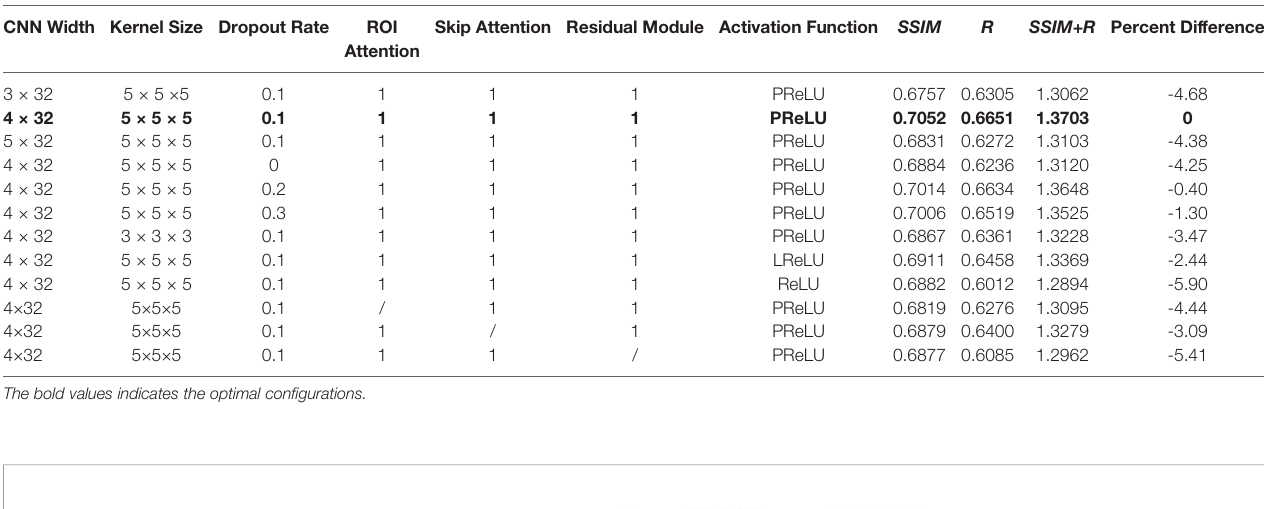
TABLE 3 | Performance of the proposed network with different CNN components and con fi gurations. CNN Width Kernel Size Dropout Rate ROI Skip Attention Residual Module Activation Function SSIM Attention